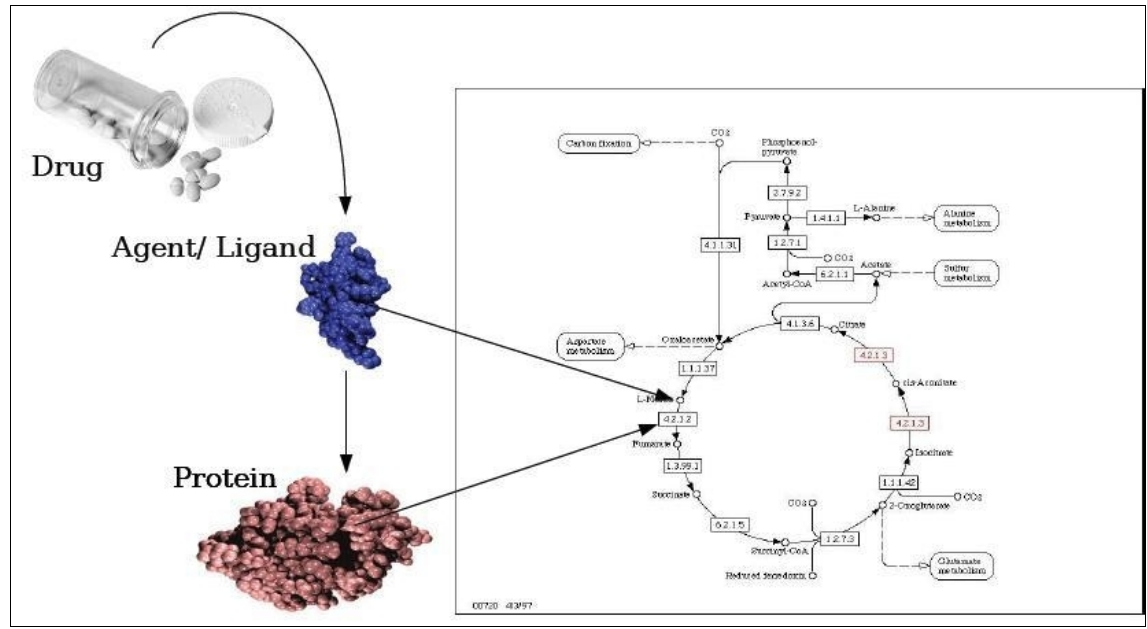
Figure 1: The figure shows the relation between medications and the metabolism. Drugs and their ingredients have a specific counterpart, mostly a protein. Agents and proteins are part of one or more specific metabolic pathways. Finding the location of medication-affected enzymes and receptors is also called